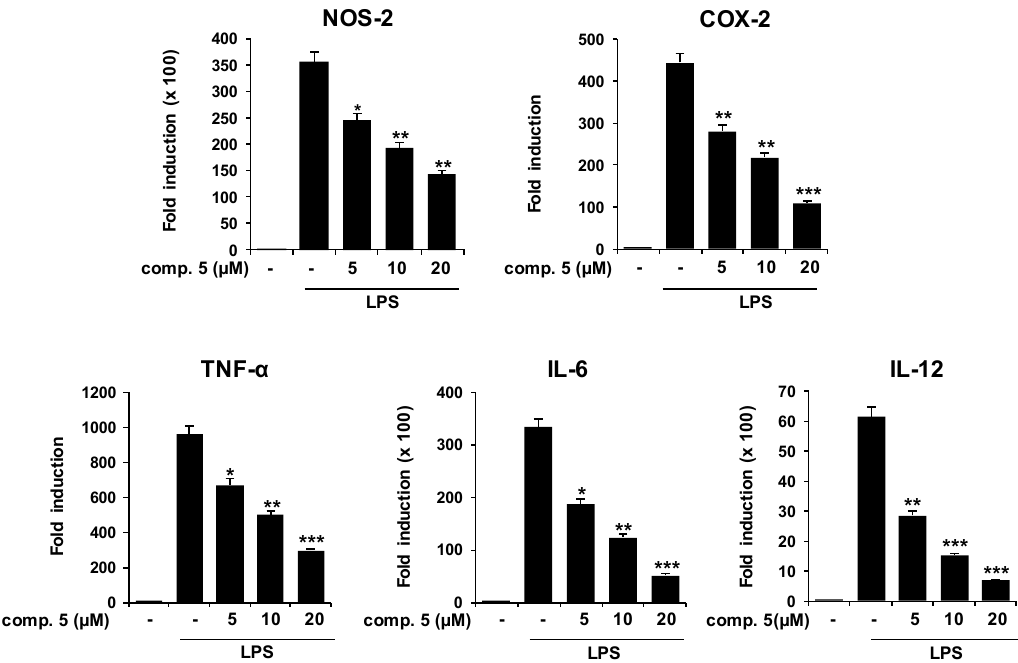
Figure 5. Diterpene 5 inhibits expression of inflammatory genes in a dose-dependent manner. Macrophages were preincubated for 30 min with compound 5 (5, 10, and 20 µ M) followed by stimulation with 200 ng/mL LPS for 4 h. Relative expression of NOS-2, COX-2, TNF- α , IL-6, and IL-12 mRNA was determined by real-time quantitative PCR. Results are the means ± SD of three independent experiments carried out in triplicate. * p < 0.05, ** p < 0.01, and *** p < 0.001 vs. the LPS condition.